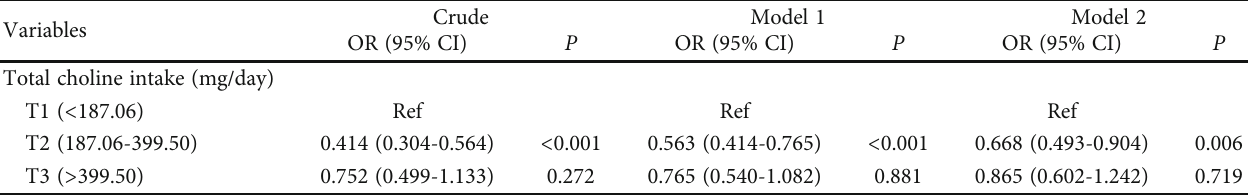
Table 2: The association between choline intake and cognitive performance assessed by the CERAD